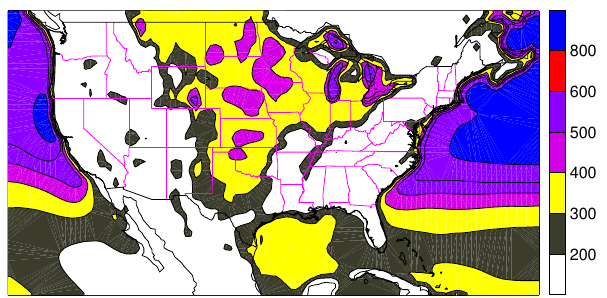
Fig. 2. Geographical variation of mean WPD (W m − 2 ) across the US.